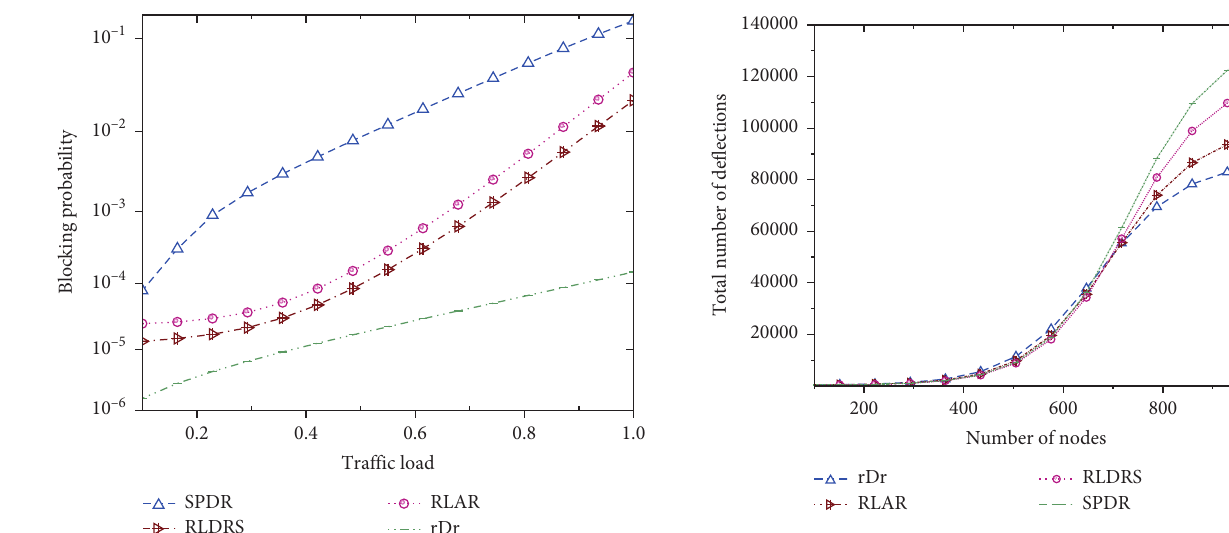
Figure 12: Blocking probability versus traffic load.